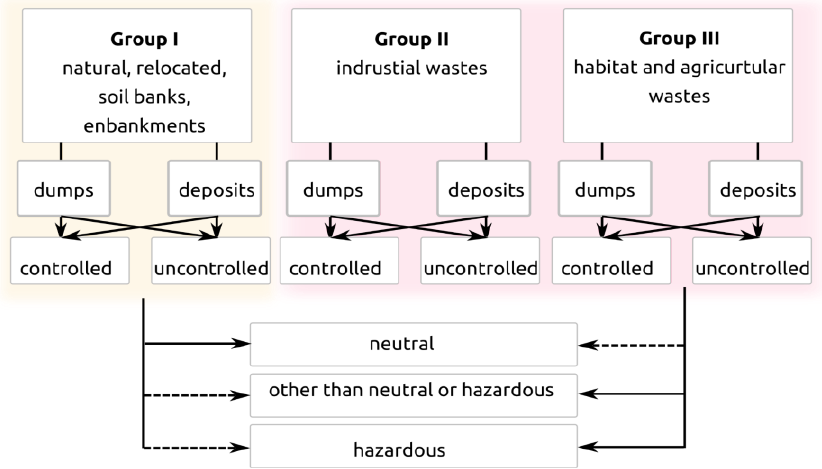
Figure 1. The division of anthropogenic soils according to standard [6].